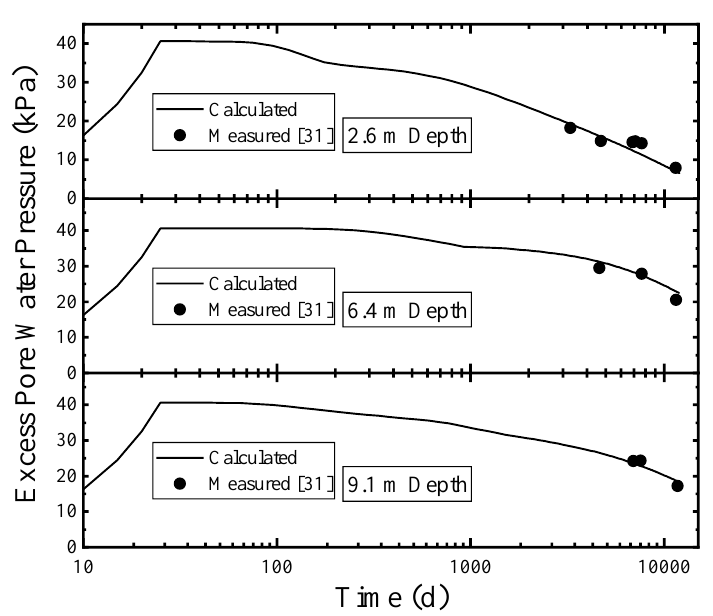
Figure 3. The diagram of the loading process.